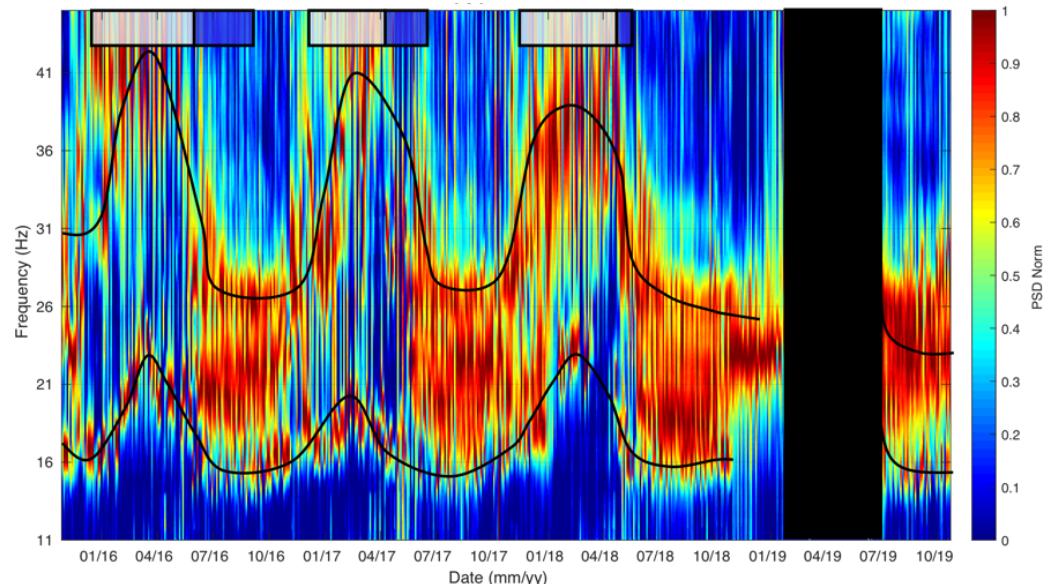
Figure 4. Normalized power spectral density (PSD) from hourly spectrograms of the ambient noise recordings of Gugla rock glacier, from C2 seismometer. Note the two bold black lines that roughly highlight the two spectral modes picked, for visibility purposes. Snow cover and melting periods are depicted by grey and blue boxes, respectively. No-data period is marked by a black